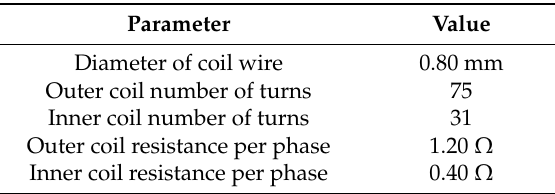
Table 3. Coil winding properties.